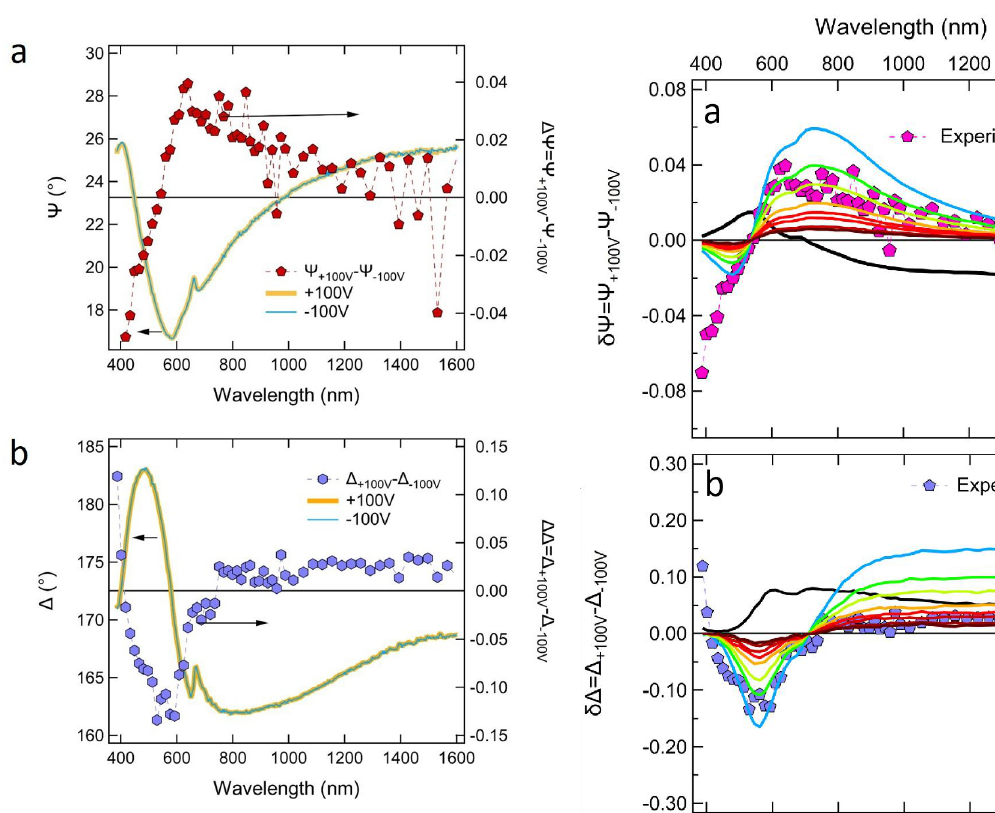
Fig. 1. a (b): Ellipsometry spectra Ψ(λ) (Δ(λ)) of 0.2 at.% AZO on top of STO (110) under bias (orange line: +100V, cyan line: -100V). Red (indigo) squares: Difference spectra δΨ(λ) (Δ(λ)), defined as Ψ(+100V)-Ψ(-100V) (Δ(+100V)-Δ(- 100V)). All spectra were acquired at T=4.2 K with an incidence angle of 45°.